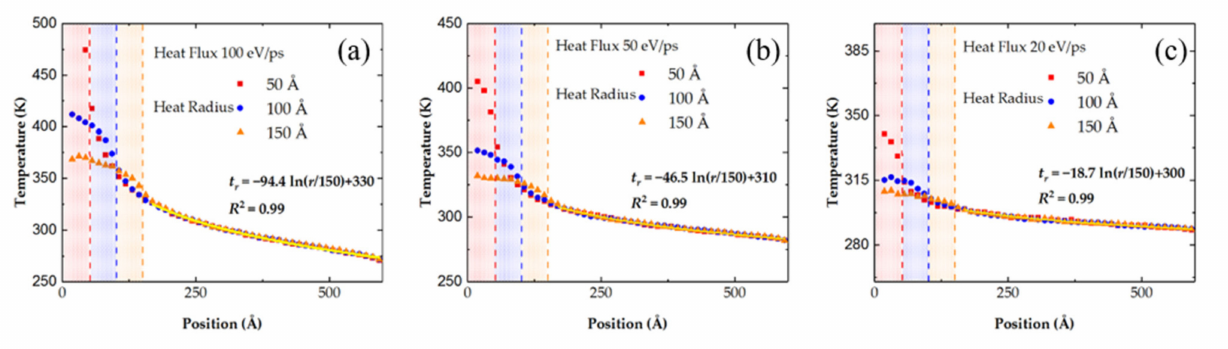
Figure 5. The temperature of graphene sheet at different positions from the interior to the boundary. The amount of heat flux is ( a ) 100 eV/ps, ( b ) 50 eV/ps, ( c ) 20